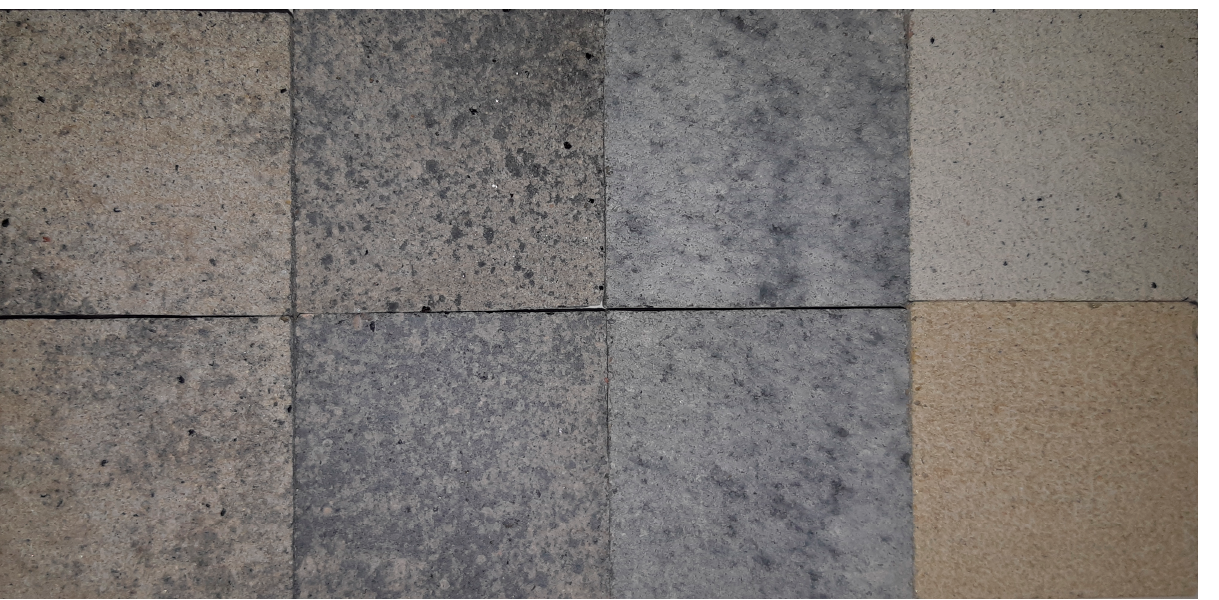
Figure 1. QUADRO samples from top to bottom: first column: Glacier 1 and 2; second column: Glacier 3 and 4; third column: Glacier 5 and 6; and fourth column: titanium and dolomite. Table 2. Description and codification of the tested samples.